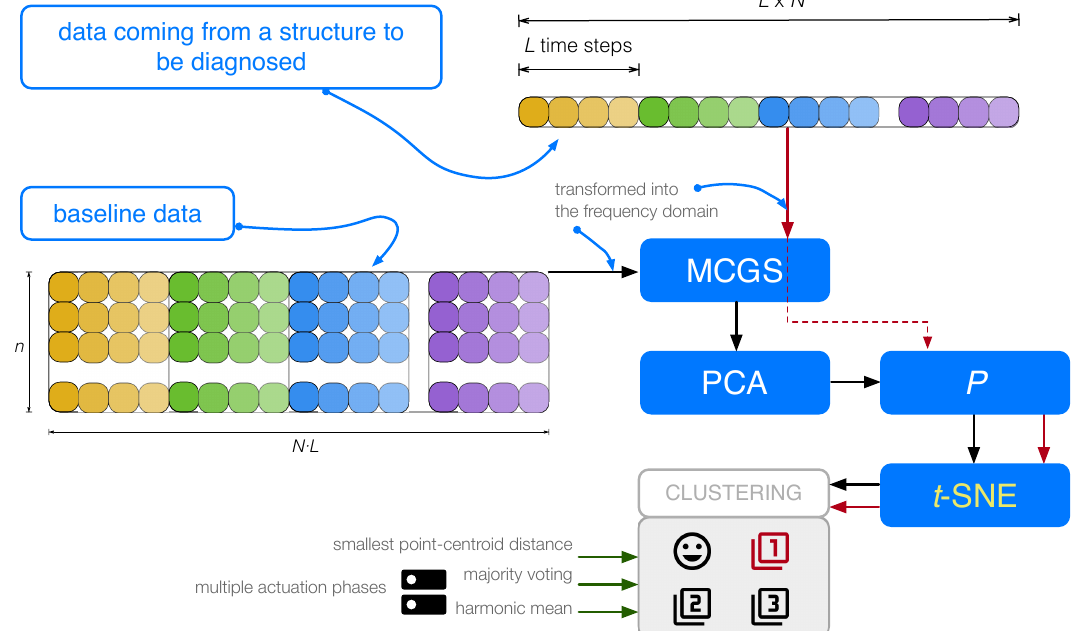
Figure 2. Flowchart of the proposed approach. Data coming from a structure are first transformed into the frequency domain and scaled, and then projected into the principal component analysis (PCA) model. Finally, t -distributed stochastic neighbor embedding ( t -SNE) is used to create the clusters that will be used in the detection and classification of structural changes. MCGS = mean-centered group